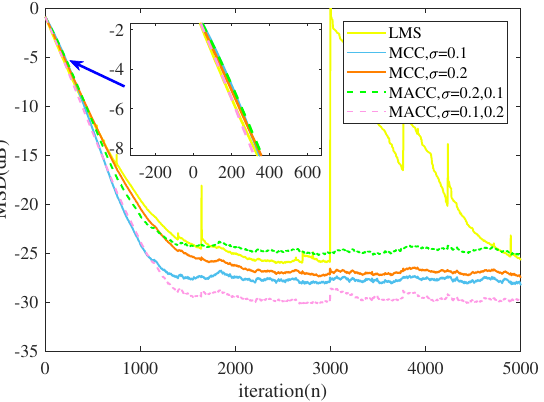
Figure 12. Steady-state performance comparison of different algorithms under asymmetric and non-Gaussian distribution